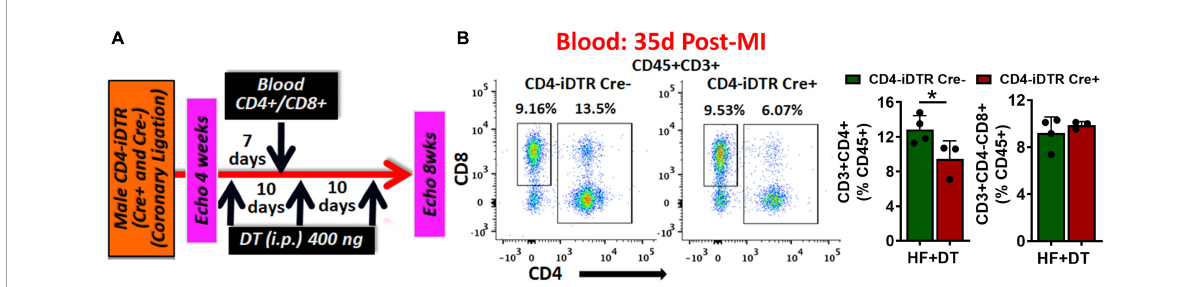
FIGURE2 (A) Experimental plan for diphtheria toxin (DT) administration in CD4-iDTR Cre + and Cre - mice from 4 to 8 weeks post-MI. DT (400 ng, i.p. ) was administered on days 28, 38, and 48 post-MI. (B) Representative flow cytometry plots for circulating CD4 + and CD8 + T-cells in CD4-iDTR Cre - and CD4-iDTR Cre + mice at 7 days post-injection ( i.p. ) of first DT dose (35 days post-MI) (left) , and their group quantitation (right). Data is shown from 1-representative experiment. Mean ± SD is shown. Unpaired 2-tailed Student’s t -test was used in (B) . * P < 0.05 represents significance with respect to the indicated groups.